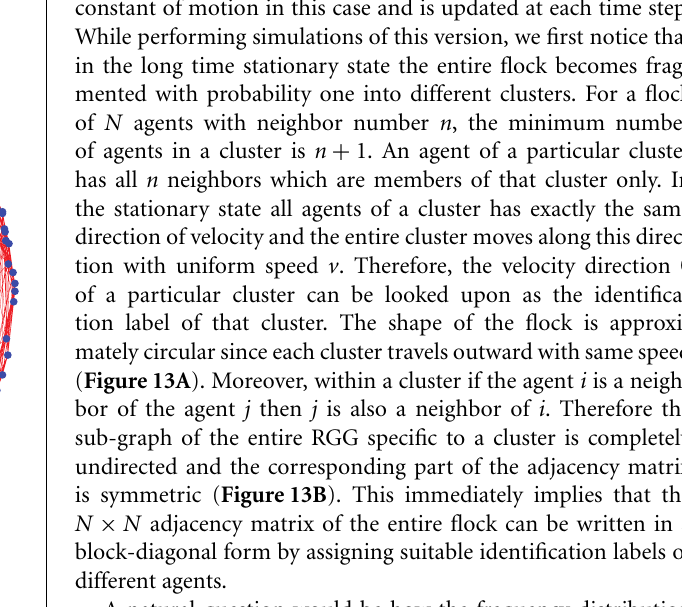
FIGURE 12 | The position of a flock ( N = 512 , n = 10) in CS by blue dots and links by red lines. The frame size is 150 units. in Figure 12 . This is the picture of the circle shaped flock in the cyclic state. The blue dots represent the agents and the red lines represent the edges. What is interesting to note is that the system self-organizes itself so that not only agents but also the edges are constrained to be within a very limited region of the space. Very few edges criss-cross the flock from one side to the opposite side. Initially each agents had its n neighbors at its closest distances. After passing through the relaxation stage and arriving at the stationary state, when the shape of the flock is com- pletely different from its initial shape, most of the agents maintain their connections with other agents in their local neighborhood